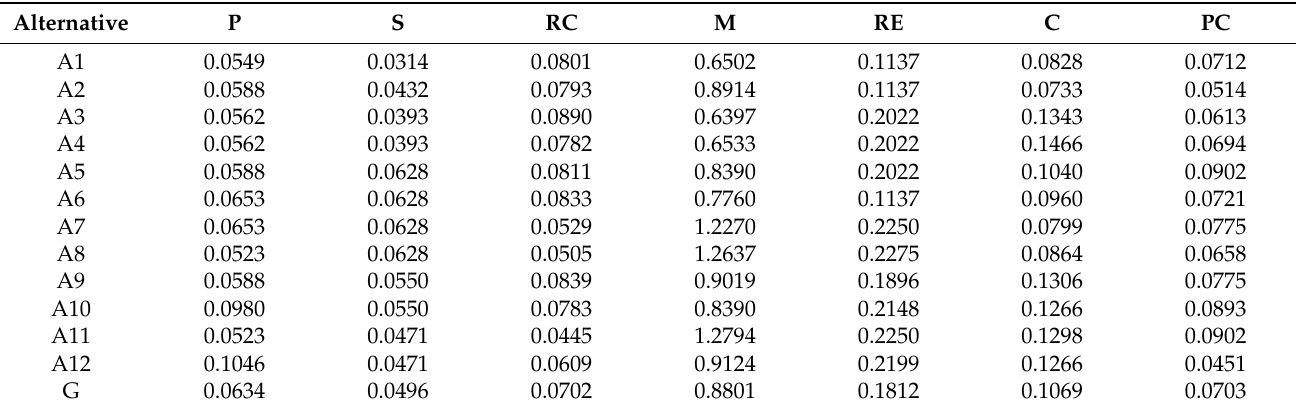
Table 10. Weighted normalized decision matrix for